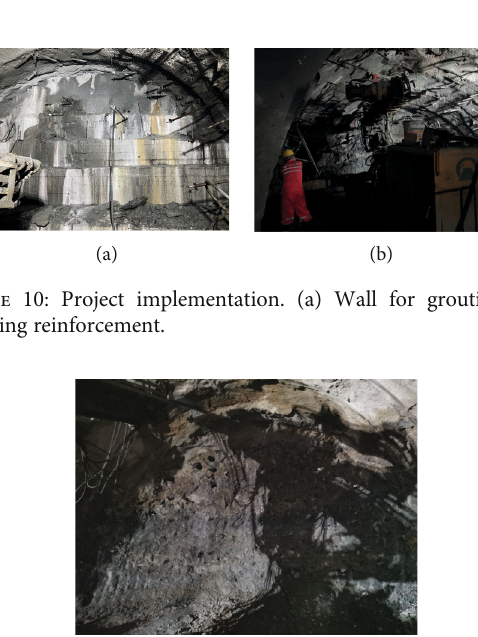
Figure 11: Probe hole after